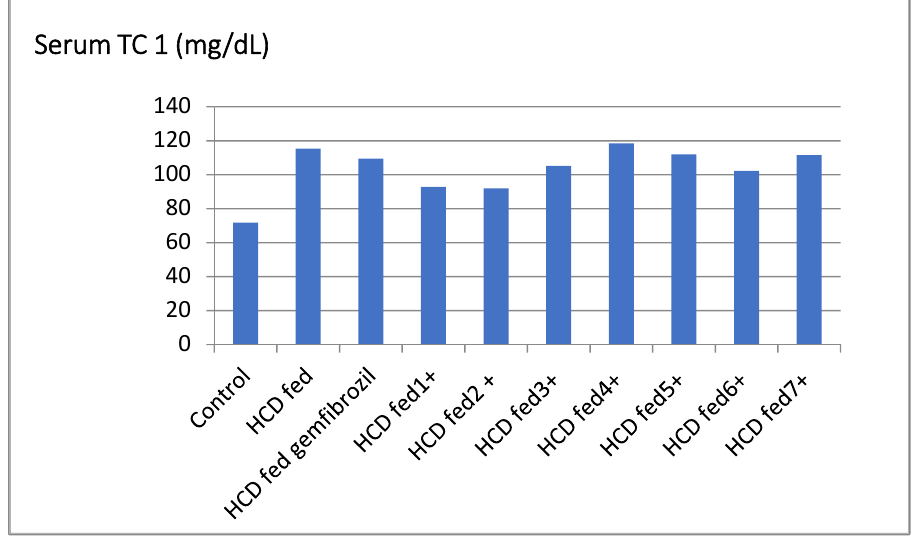
Figure 1. Effect of the tested compounds and gemfibrozil on serum TC of hyperlipidemic rats. The compounds 6 and 7 lowered serum TG levels in hyperlipidemic rats by 28.77% and 24.45%, respectively, and are more active than the standard gemfibrozil, which only reduced serum TG levels by 22.68%. Furthermore, compounds 2 , 4 , and 7 elicited rather minor action (Table 1, Figure 2).